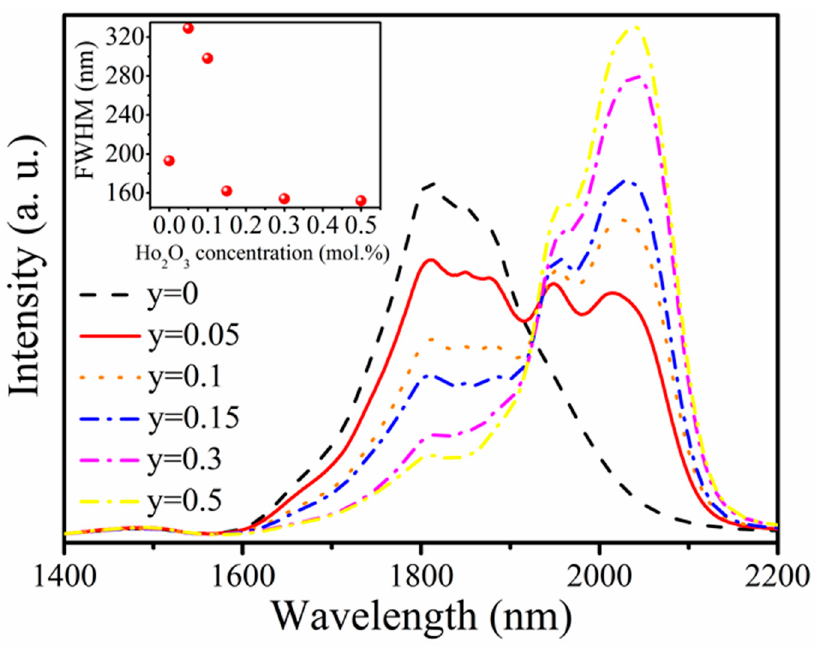
Figure 4. Fluorescence spectra of TGBTH-y glasses pumped by 800 nm LD. The inset shows Ho 2 O 3 concentration dependence of full width at half maximum (FWHM).